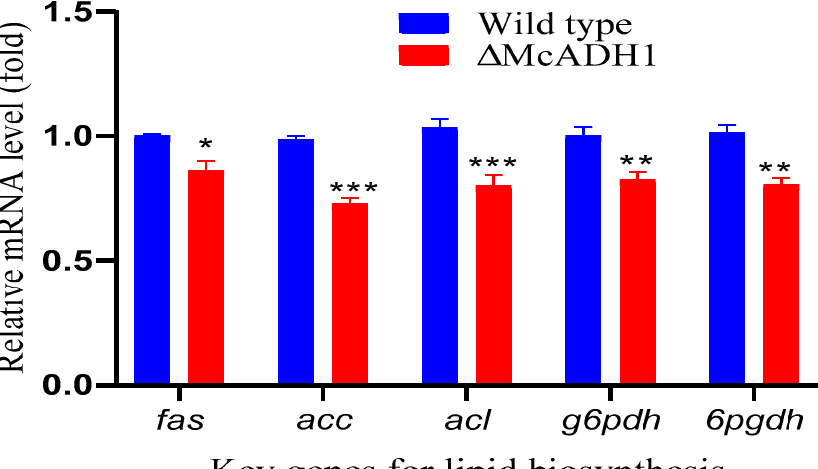
Figure 3. Lipid biosynthesis key genes expression in adh1 knockout strain. RT-qPCR was used to determine relative mRNA levels of fatty acid synthase ( fas ); acetyl-CoA carboxylase ( acc ); ATP: citrate lyase ( acl ); glucose-6-phosphate dehydrogenase ( g6pdh ); 6-phosphogluconate dehydrogenase ( 6pgdh ) at 48 h of fermentation time. The values are the means of three biological replicates and asterisks indicate significant differences: * p < 0.05, ** p < 0.01, *** p < 0.001.